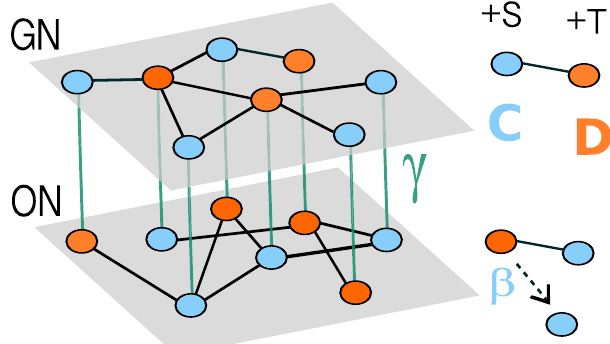
Figure 1. Graphical illustration of the multiplex model. Different layers denote the different networks that individuals participate: on the top the Game Network (GN) and on the bottom the Opinion Network (ON). Intra-links (black solid lines) correspond to the individuals’ connections within each network, while inter-links (green solid lines) indicate the coupling between layers. On the right, the pictures show a simplification of the dynamic occurring on each